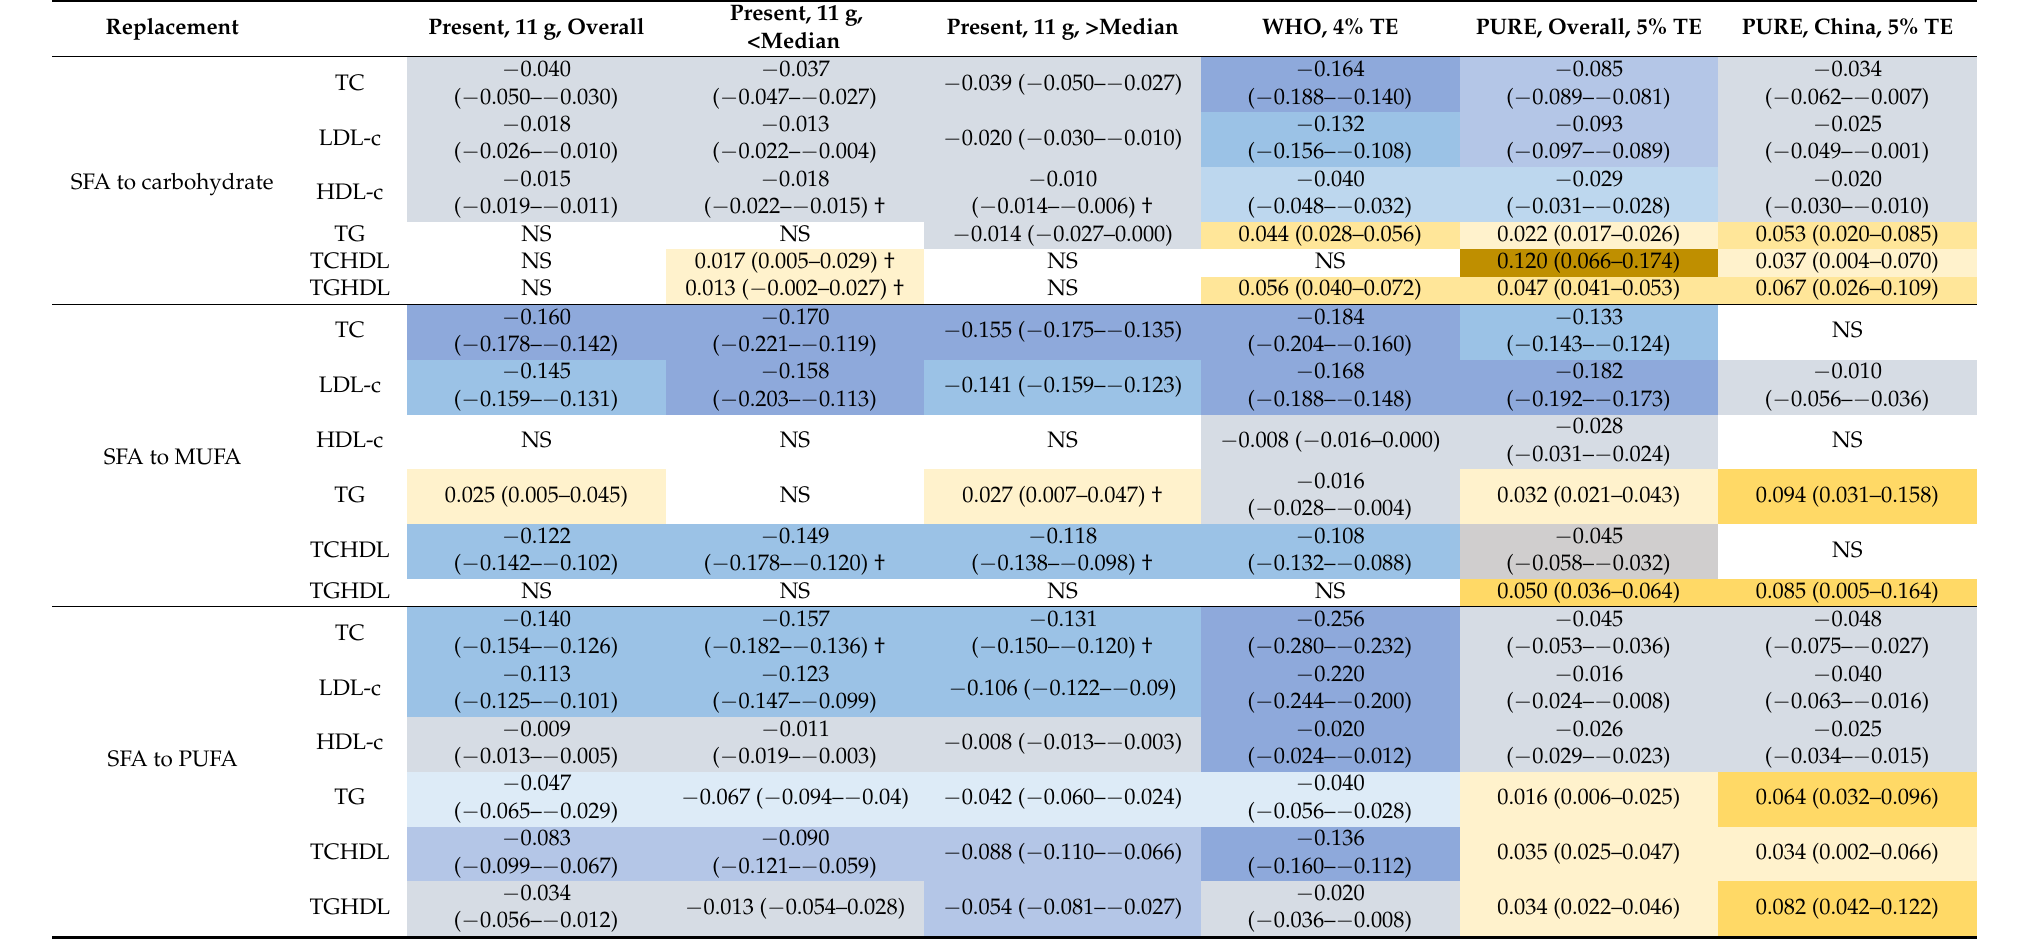
Table 6. Comparison with WHO review and PURE study in changes of lipids biomarkers when replacing SFA with other nutrients